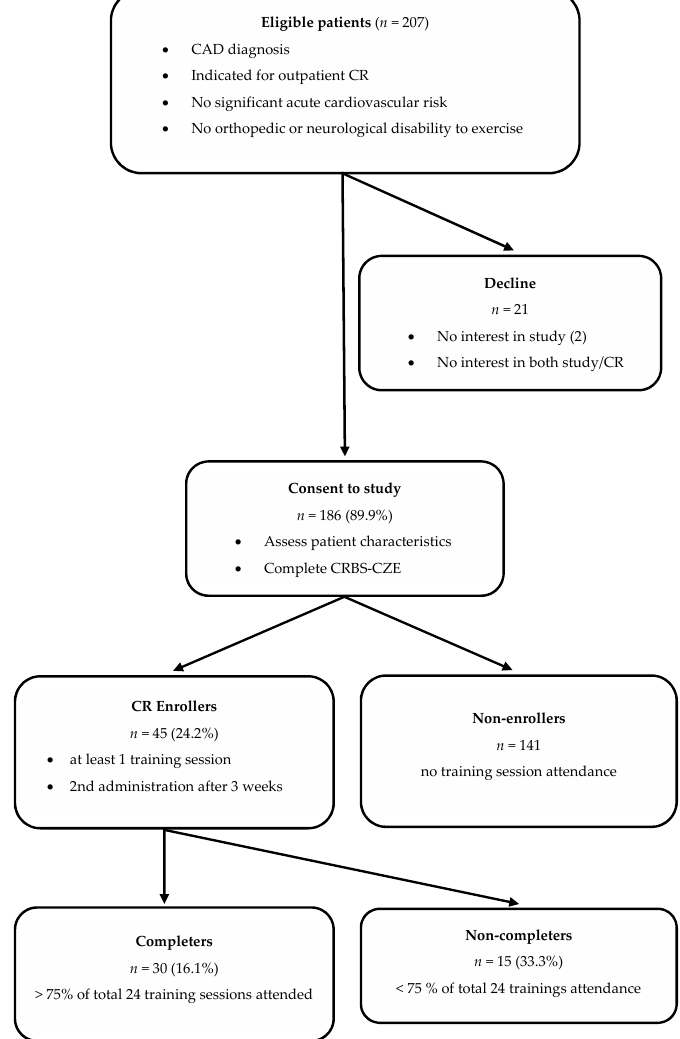
Figure 1. Flowchart of the study.